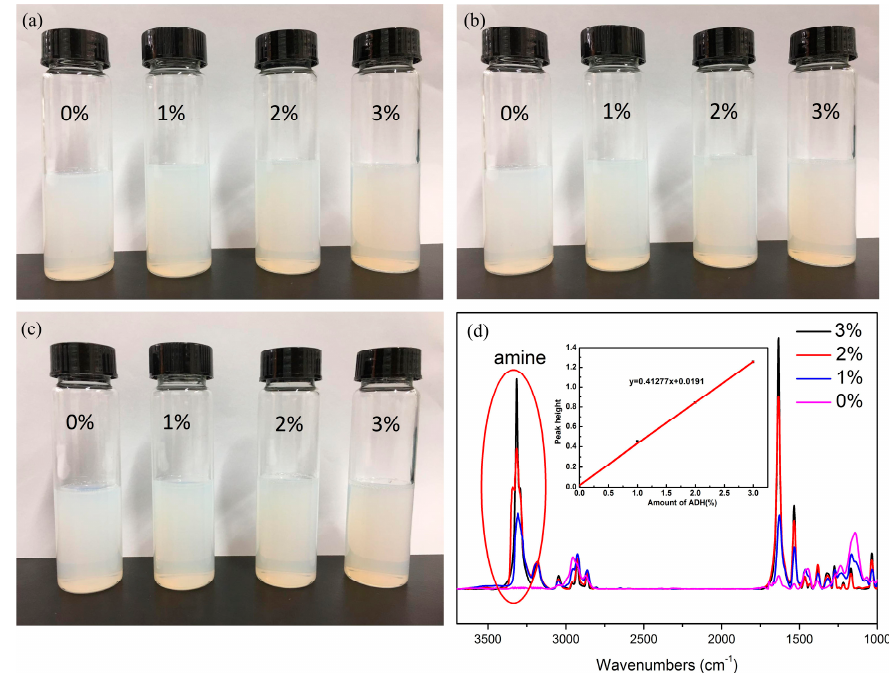
Figure 3. A diagram of stability of polymer emulsion with different amounts of ADH addition at different times: ( a ) 0 h, ( b ) 12 h, ( c ) 24 h. ( d ) FTIR spectrum of ADH/poly(methyl methacrylate-butyl